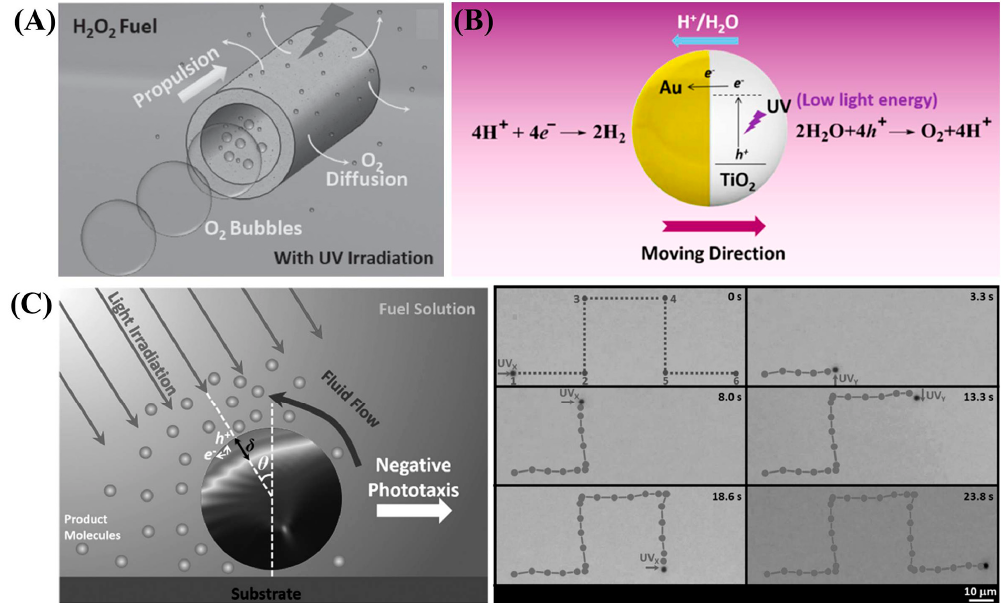
Figure 7. UV light-powered MNMs. ( A ) The UV-induced bubble propulsion mechanism of the TiO 2 tubular microengine in H 2 O 2 fuel, the generated O 2 bubbles are ejected from a one-end large opening to propel the TiO 2 tubular microengine. Reproduced with permission [100]. Copyright 2015, WILEY-VCH; ( B ) The mechanism schematic of TiO 2 − Au Janus micromotors powered by UV light in water. Reproduced with permission [79]. Copyright 2016, American Chemical Society; ( C ) The mechanism illustration of the phototaxis of a spherical TiO 2 micromotor based on the limited penetration depth of light (graph on the left). Time-lapse images and the motion trajectory of a TiO 2 micromotor in an aqueous solution containing 0.001 wt % H 2 O 2 as fuel. The predesigned pathway for the micromotor is represented as dashed–dotted lines (graph on the right). Reproduced with permission [101]. Copyright 2017, WILEY-VCH.